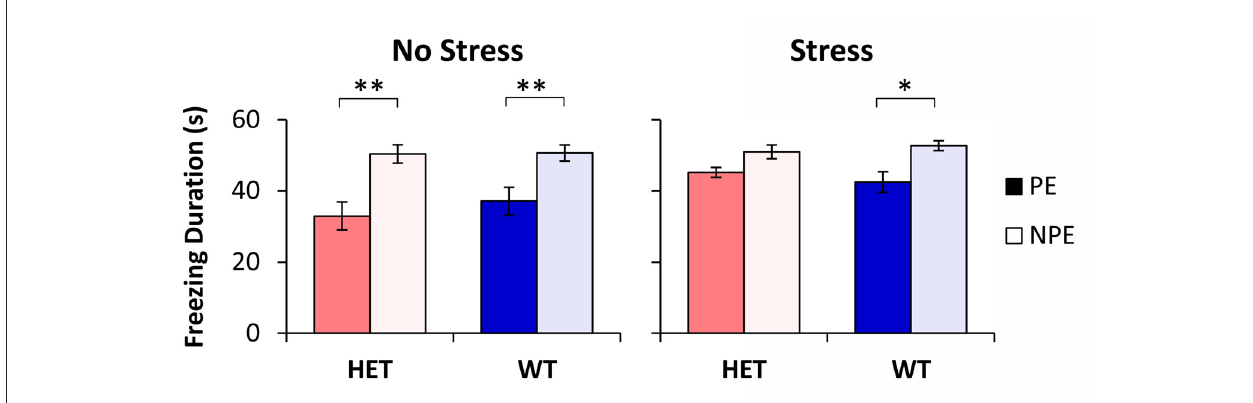
FIGURE 1 | Latent inhibition (LI) by stress and genotype. Average duration of freezing ( ± SEM) to the pre-exposed (PE) and non-pre-exposed (NPE) stimulus in glial-derived neurotrophic factor (GDNF) heterozygotes (HET) and wild type (WT) littermate controls under no-stress (left) and chronic unpredictable stress (CUS; right). A significant LI (significantly larger freezing to NPE than PE) was observed in all groups except in stressed GDNF HET mice. ∗ p < 0.05; ∗∗ p < 0.01.